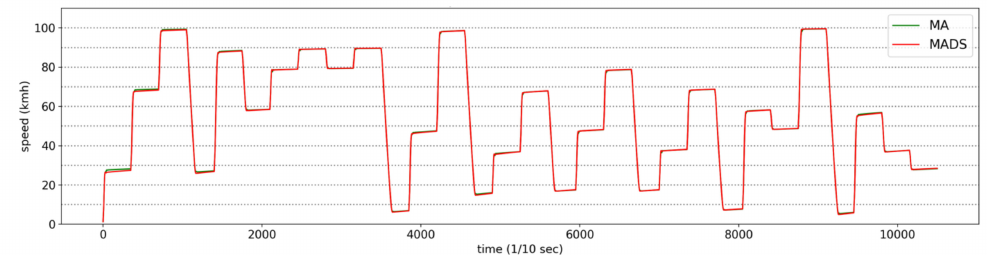
Figure 6. Representation of the performance of MADS versus MA optimized controllers.